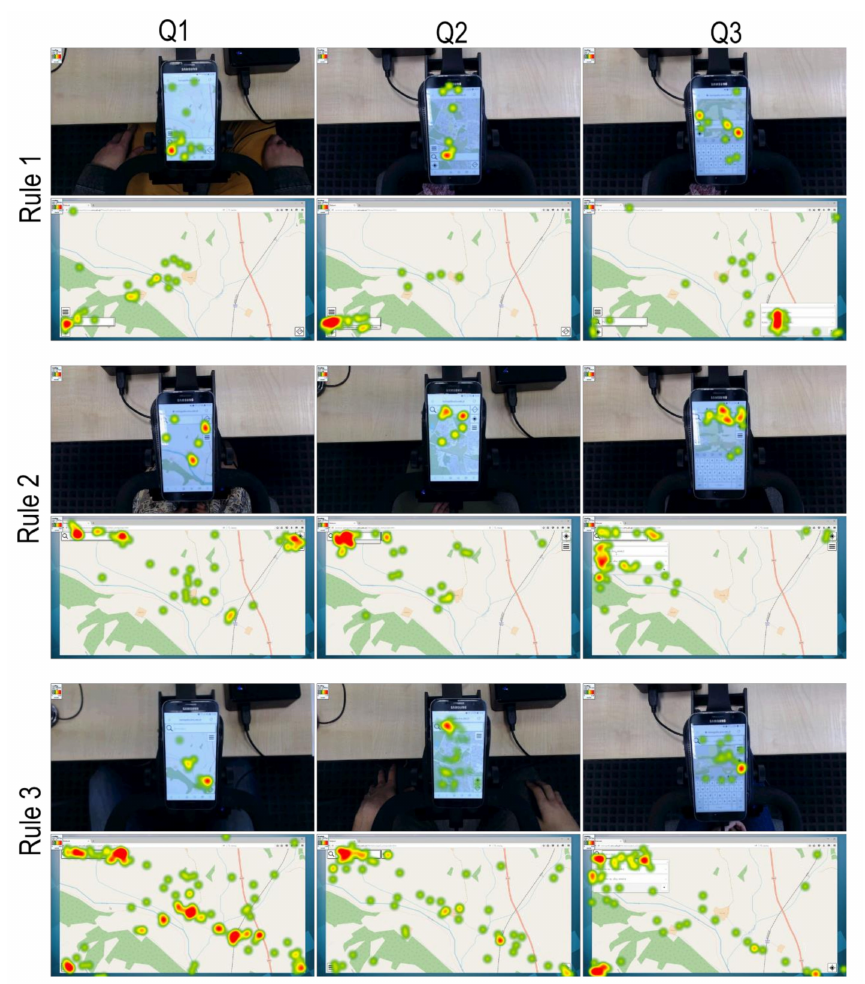
Figure 5. Eighteen heat maps presenting the spatial distribution of fixations in each task for the three rules on the computer monitor and on the smartphone (compare to Figure